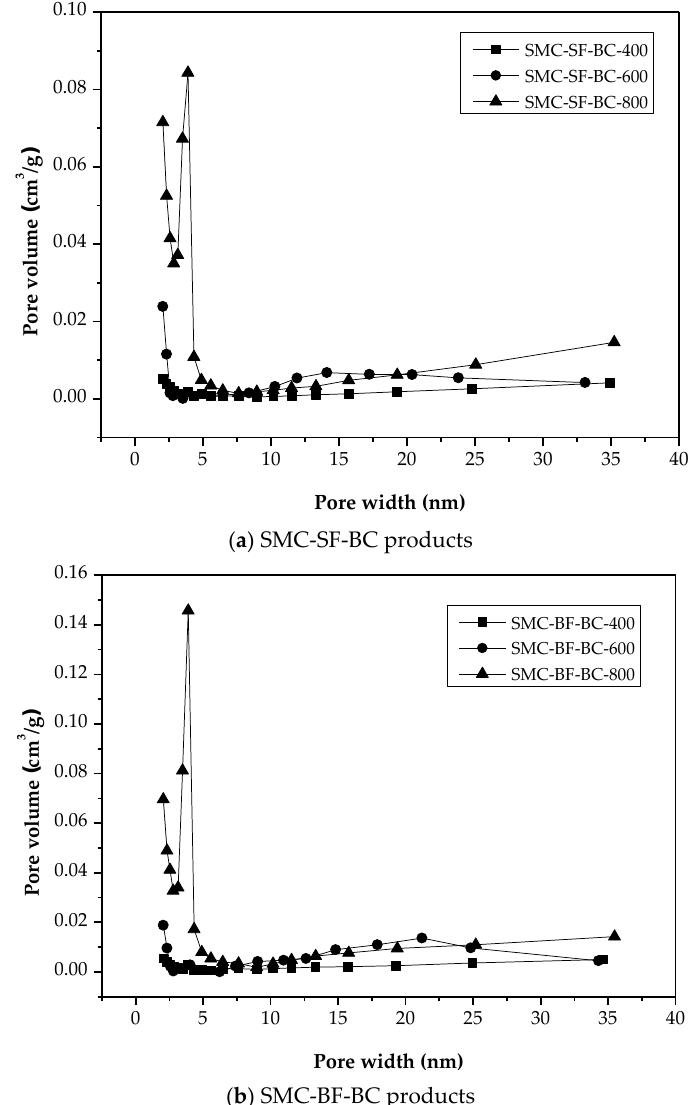
Figure 4. Pore size distribution curves of ( a ) SMC-SF-BC products and ( b ) SMC-BF-BC products.